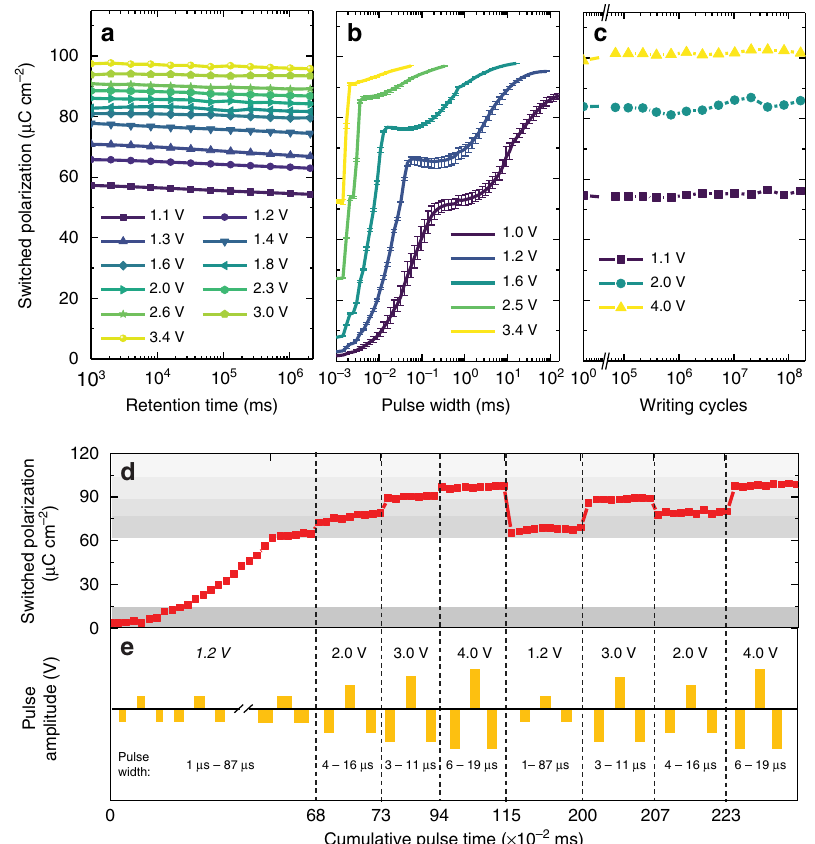
Fig. 5 Properties of multi-state polarization in heterostructures. a Retention measurements probing the time stability of the intermediate-polarization states. b Repeatability measurements wherein the error bars were generated after repeating each pulse-switching measurement 10 times. c Endurance measurements of the switched polarization as a function of writing cycles. d Demonstration of on-demand switching ability including ascending and arbitrary access to any desired polarization state by simultaneously controlling the pulse duration and amplitude. e The schematic illustration of pulse series used in